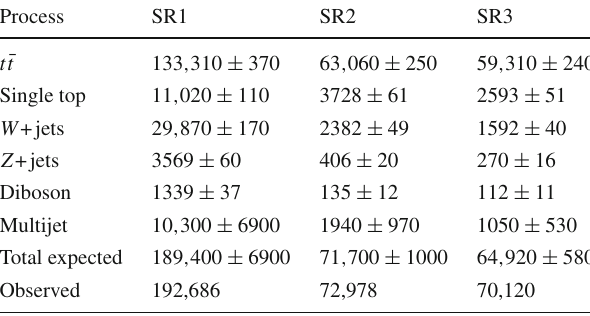
Table 1 Event yields for the three signal regions. The multijet back- ground and its uncertainty are estimated from the E miss to data. All the other expectations are derived using theoretical cross- sections, and the corresponding Monte Carlo sample statistical uncer-